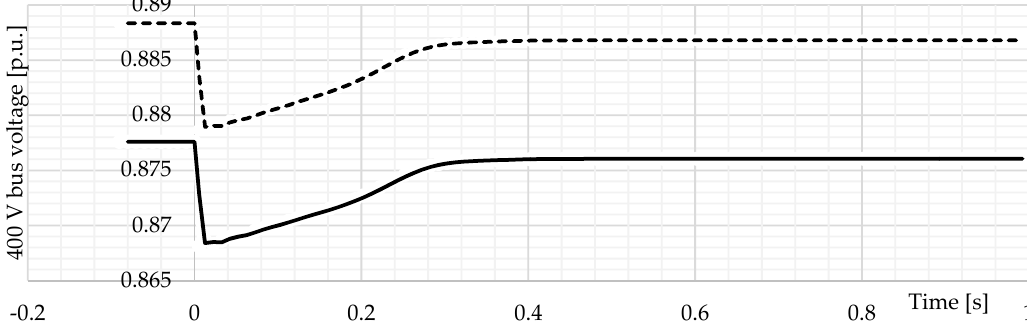
Figure9. Voltagevaluesduringthe110kWasynchronousmotorstart(withoutSVCimplemented—solid Figure 9. Voltage values during the 110 kW asynchronous motor start (without SVC implemented— line, with SVC implemented—dashed solid line, with SVC implemented—dashed line).